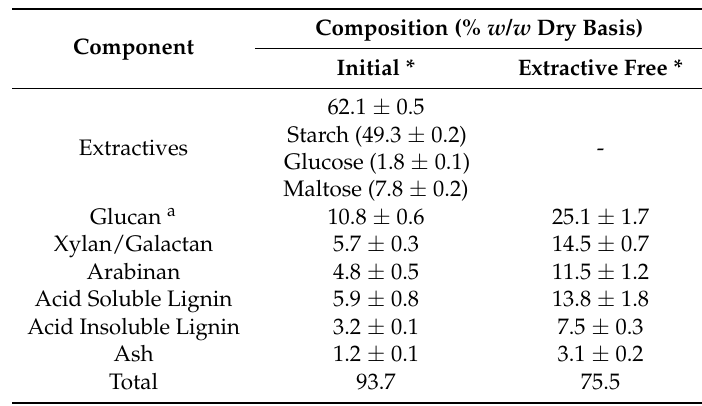
Table 2. Composition analysis of